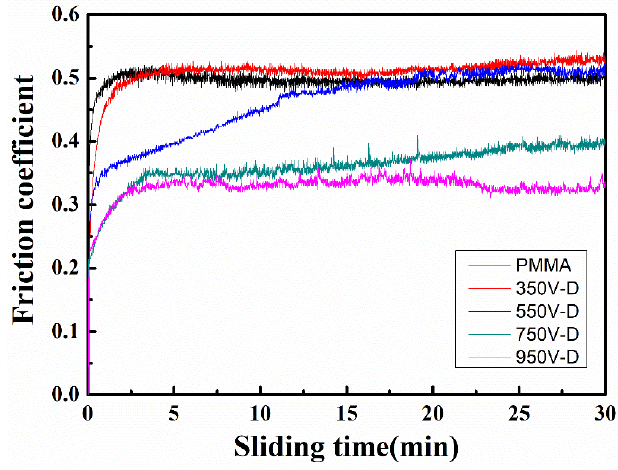
Figure 10. Friction coefficient curves of PMMA and the films prepared on Ti/PMMA at a different substrate bias with conductive materials.